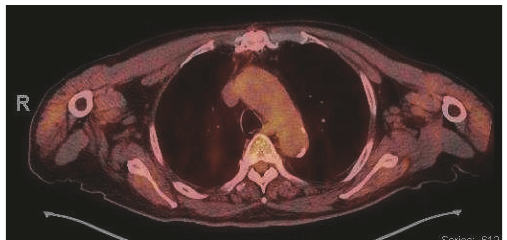
Figure 4: PET scan showing a right upper lobe lung mass without any hypermetabolic activity.